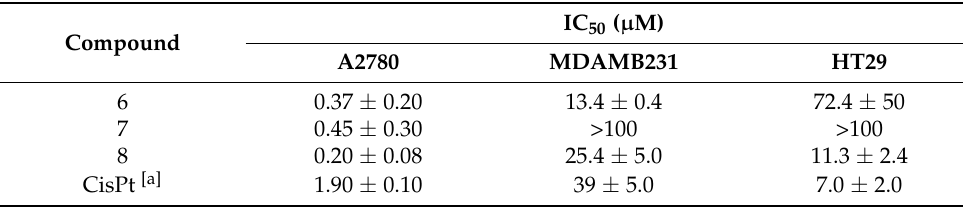
Table 4. In vitro cytotoxic activity of complexes 6 – 8 against A2780 ovarian, MDAMB231 breast, and HT29 colon adenocarcinoma at 72 h measured as half-inhibitory concentration IC 50 . Data are represented as mean ± SD of n = 3 independent